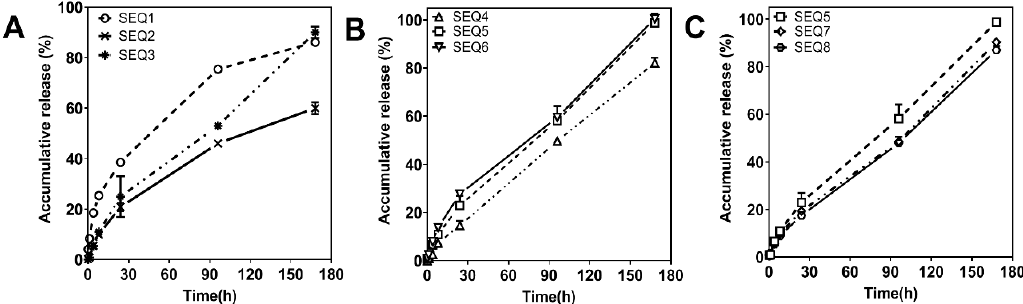
Figure 2. In vitro release profiles of ABMs with different SEQs. ( A ) Different types of PLGAs; ( B ) Different stirring rate of emulsification; ( C ) Different ratios of AB to PLGA (Mean ± SD).